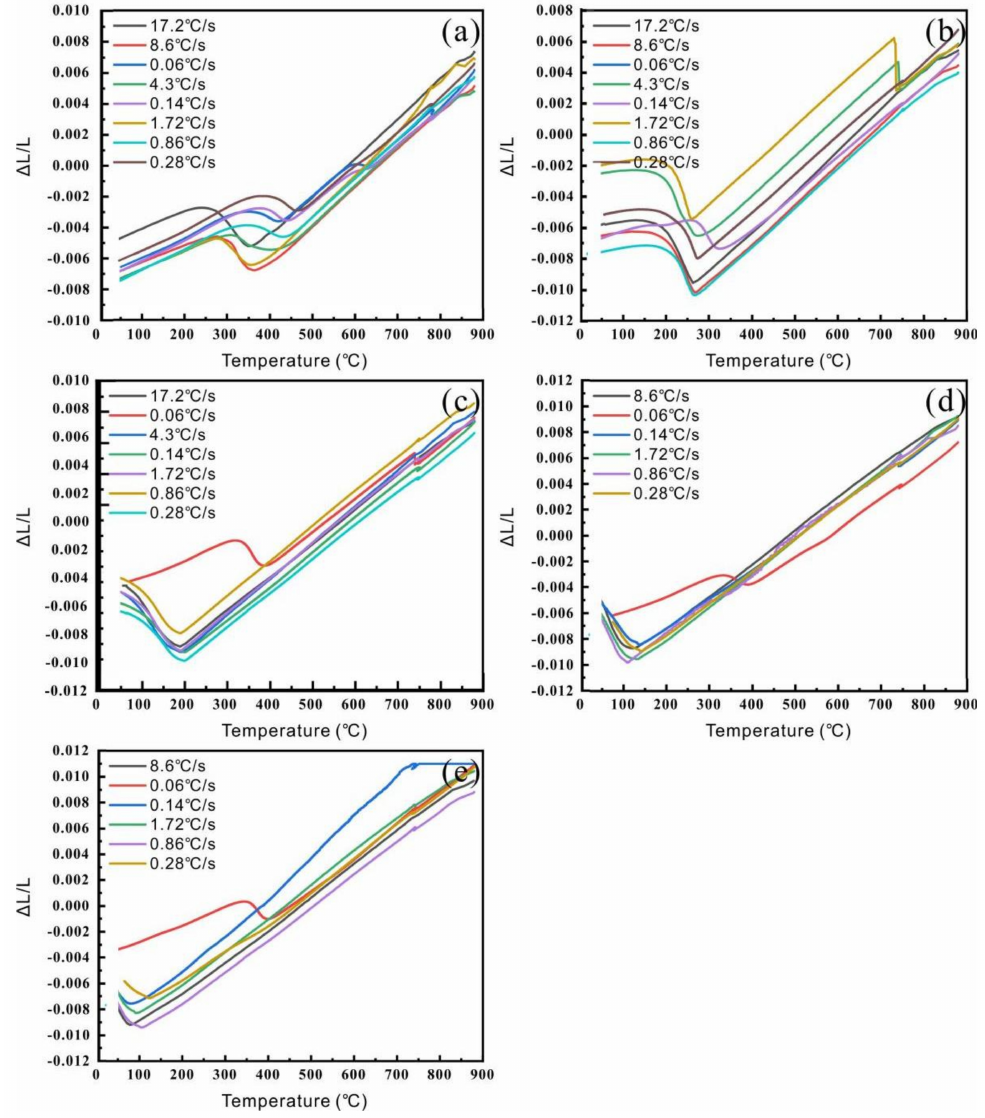
Figure 4. The thermal expansion curves with different samples at different cooling rates: ( a ) 20Cr; ( b ) 40Cr; ( c ) 60Cr; ( d ) 80Cr; ( e )